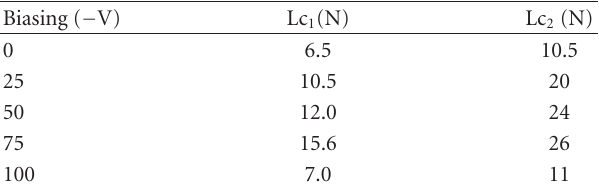
Table 4: E ff ect of biasing on critical loads during scratch tests for NbN coatings on SS.